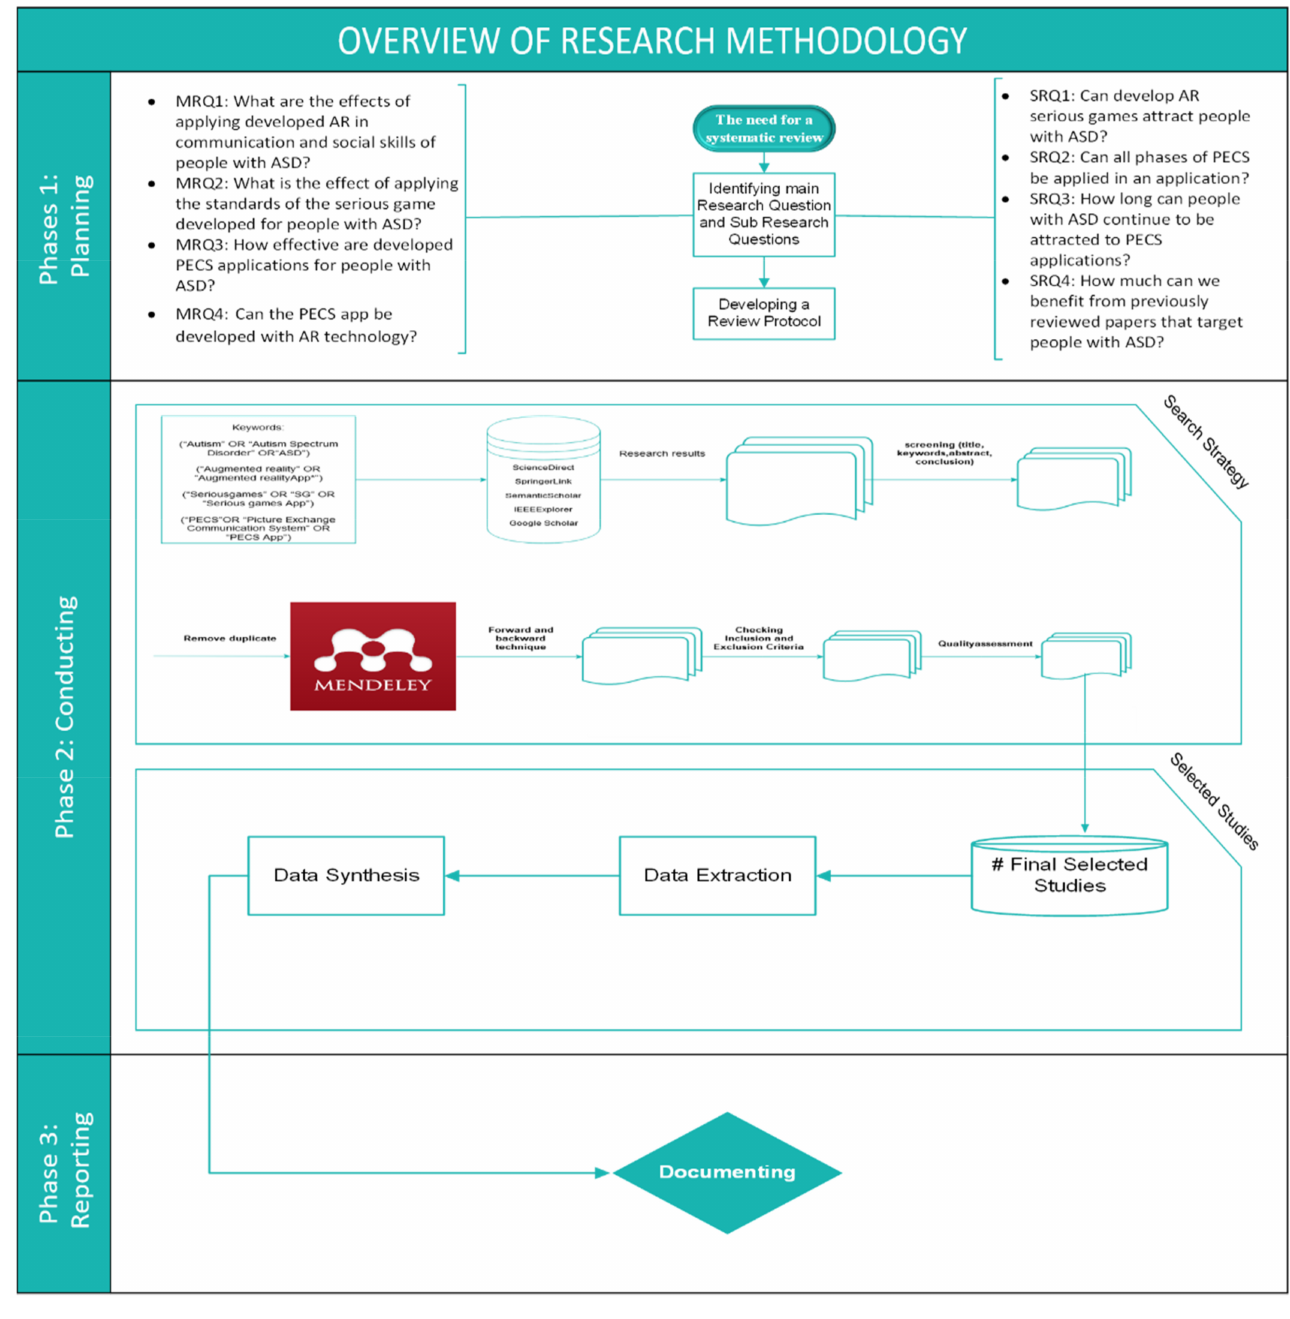
Figure 7. Overview of the research